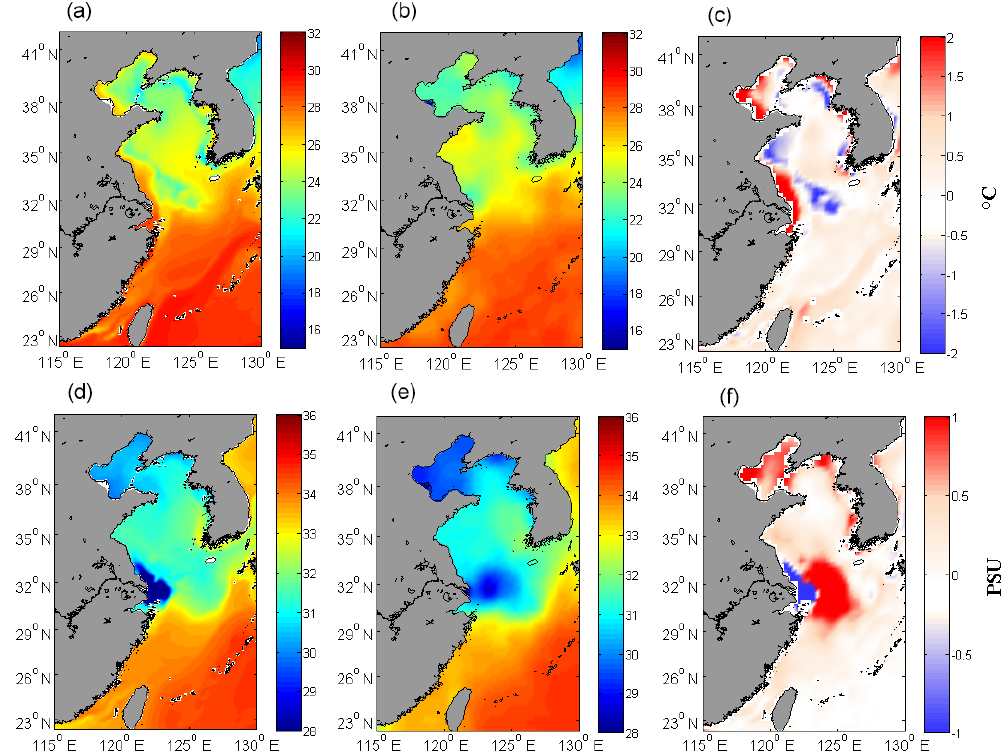
Figure 2. The comparison between modeled results (a) and GDEM data (b) of climatological field of SST in August, and the difference between them (c) . The comparison between modeled results (d) and GDEM data (e) of climatological field of SSS in August, and the difference between them (f) .